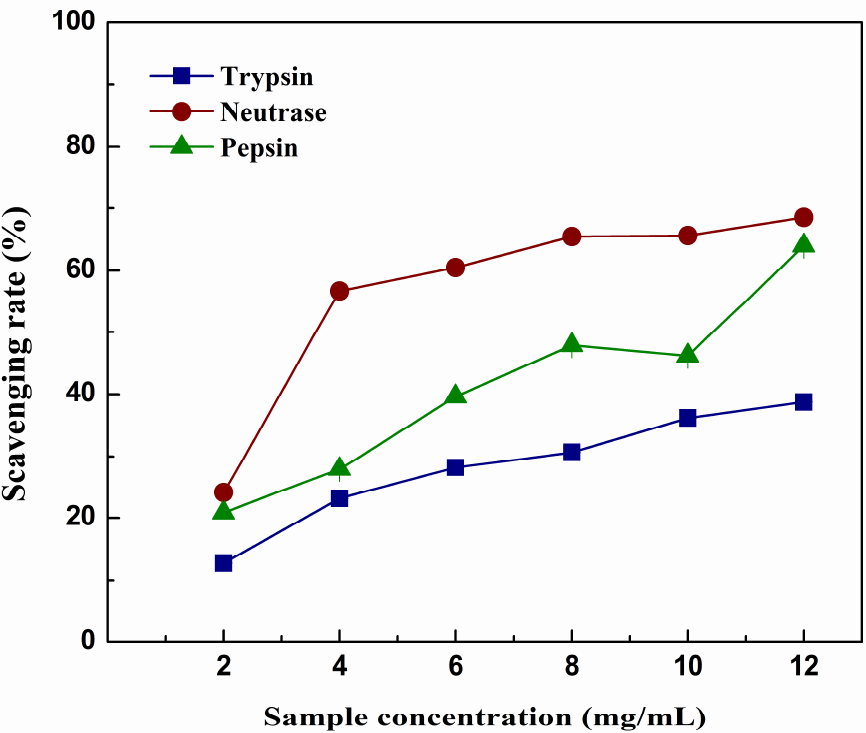
Figure 4. DPPH (2,2-diphenyl-2-picrylhydrazyl) free radical scavenging activities of 4 h hydrolysates during hydrolysis by trypsin, neutrase, and pepsin with different concentrations. Results represent means ± SD of three independent experiments.